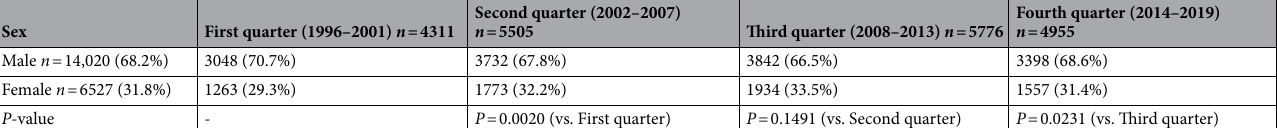
Table 2. Sex distribution of new-onset hepatocellular carcinoma cases in each quarter. Data are expressed as counts